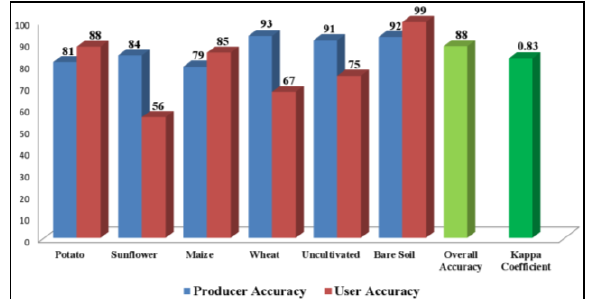
Figure 7. Producer’s, User’s and Overall accuracies and Kappa coefficient assessment of multi-temporal Sentinel-1 SAR data (percentages are rounded to the nearest